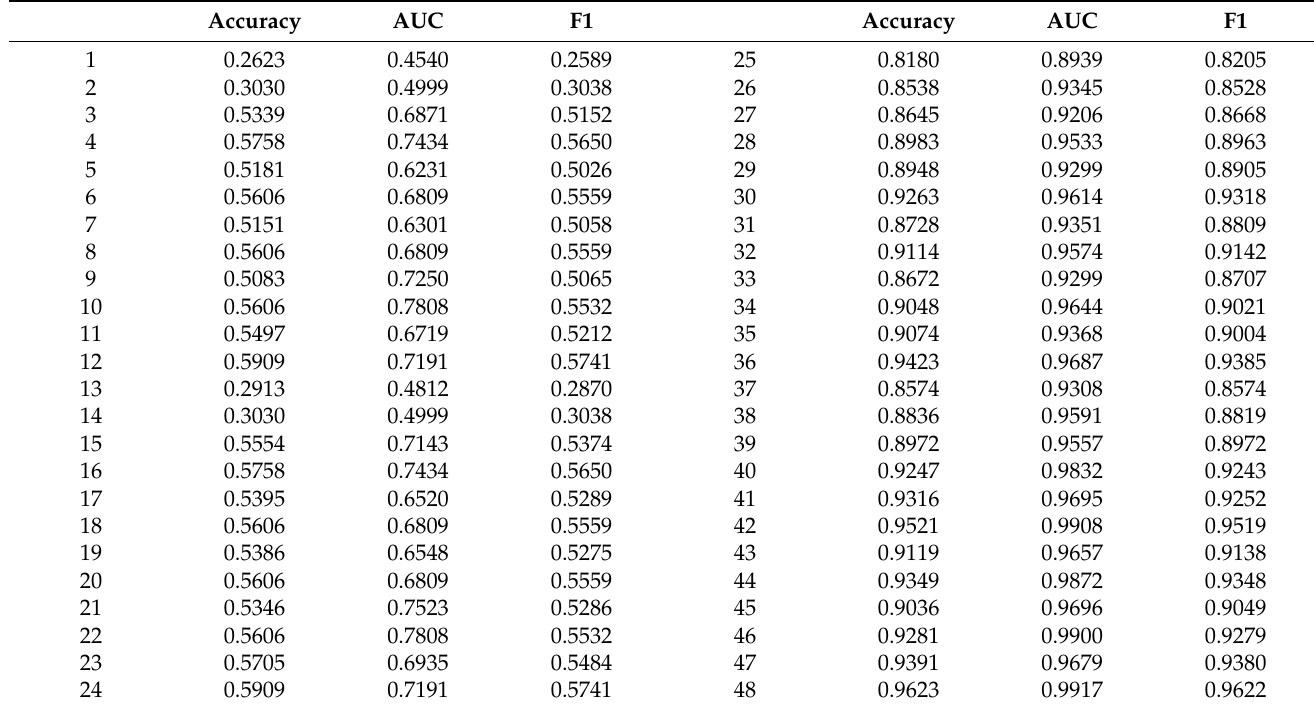
Figure 7. Experimental framework of the proposed model and application. Table 6. KPIs of the proposed methods classifying the UTS of the weld seam.